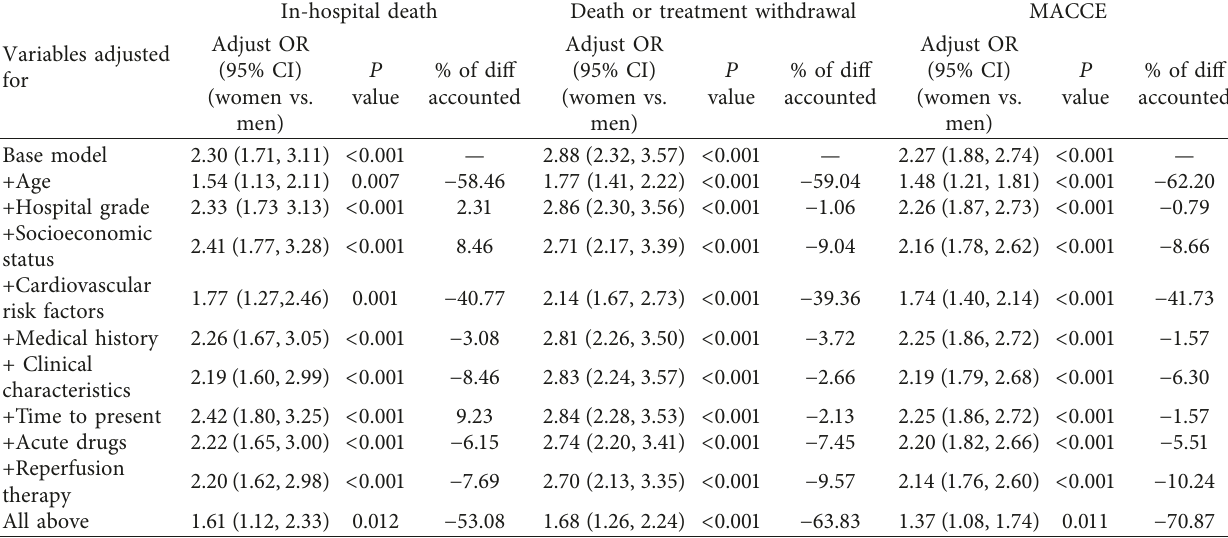
Table 3: Odds ratio for in-hospital death, death or treatment withdrawal, and MACCE in women over men with adjustment for a different set of variables, and percent of the gender-associated hazard difference accounted by each set of explaining variables. Variables adjusted